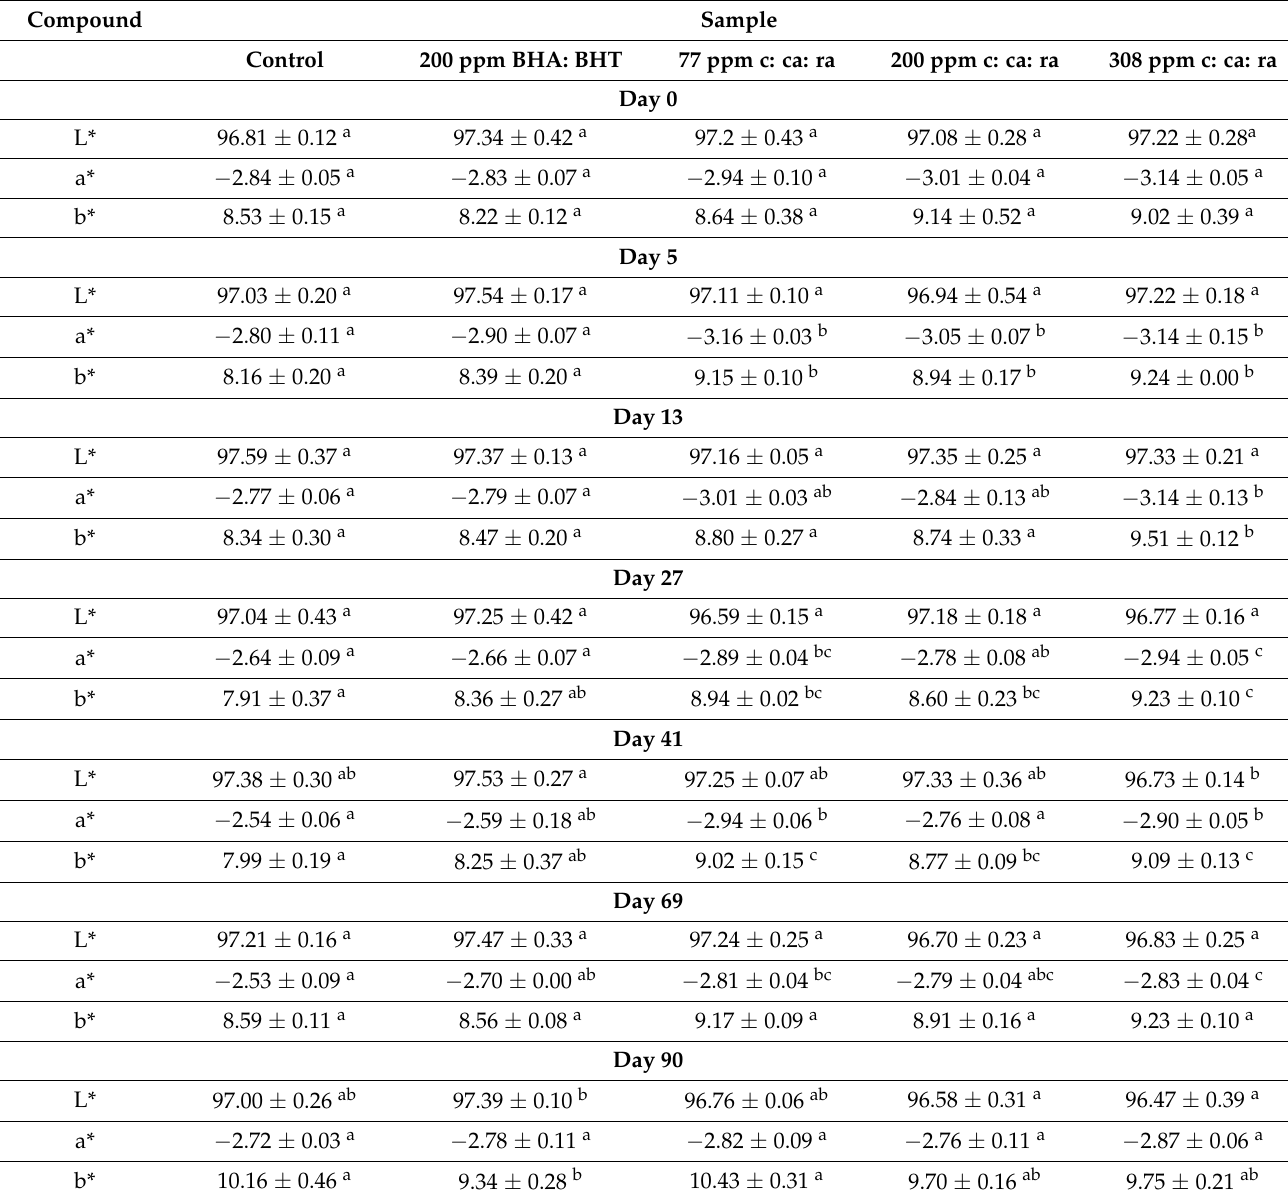
Table 2. Changes of the L* coordinate (lightness), a* coordinate (redness/greenness) and b* coordinate (yellowness/blueness) of FFMPs, before and after accelerated storage (40 ◦ C, RH 23%), with or without the addition of antioxidants 1, 2, 3 . Compound Sample Control 200 ppm BHA: